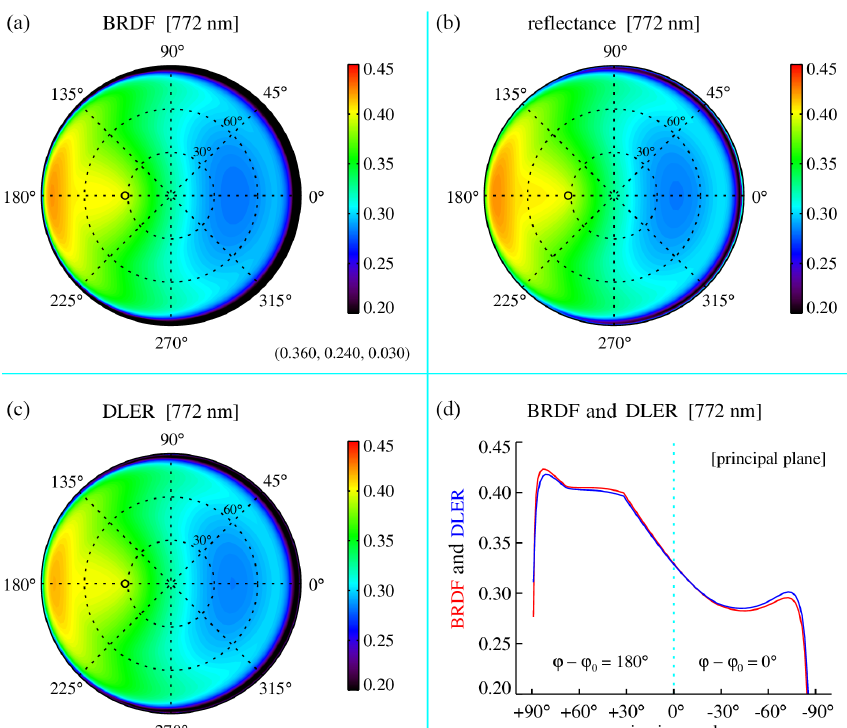
Figure 3. (a, b) Surface BRDF at 772nm for a solar zenith angle of 32 ◦ and the resulting simulated TOA reflectance. The BRDF kernel coefficients ( f iso , f vol , and f geo ) were set to (0.36, 0.24, and 0.03), representative of vegetation. (c, d) Retrieved surface DLER and BRDF– DLER in the principal plane. In the principal plane, where φ − φ 0 is 0 ◦ or 180 ◦ , exact backscattering occurs at a viewing angle of 32 ◦